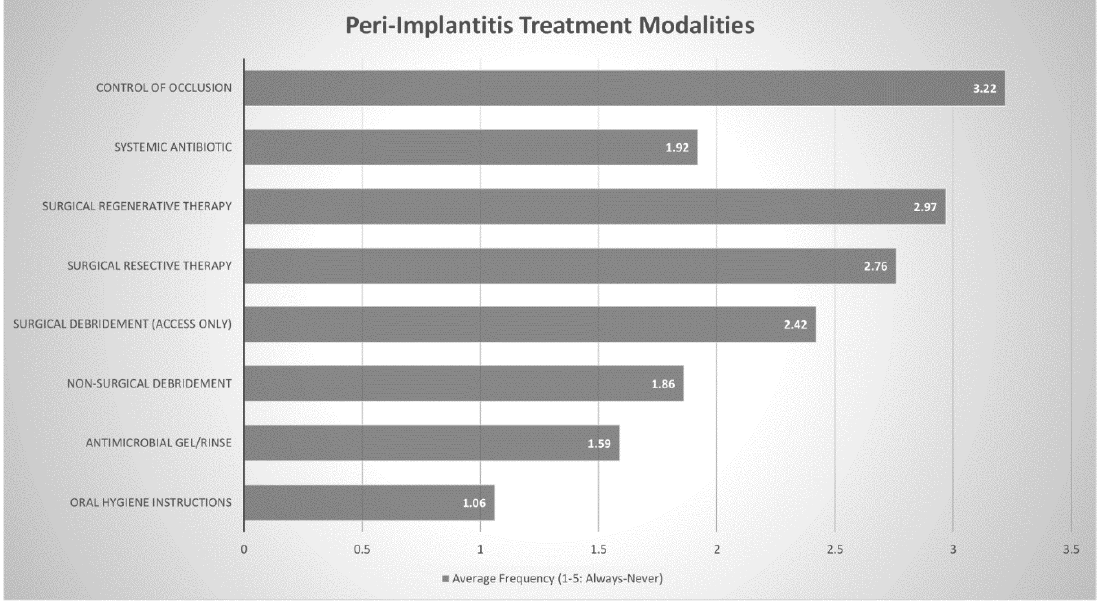
Figure 4. Peri-implantitis Treatment Modalities Frequency (Always (1) through to Never (5)).